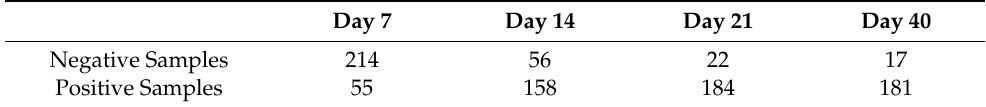
Table 1. Number of individuals with positive antibody detection at different days post infection.